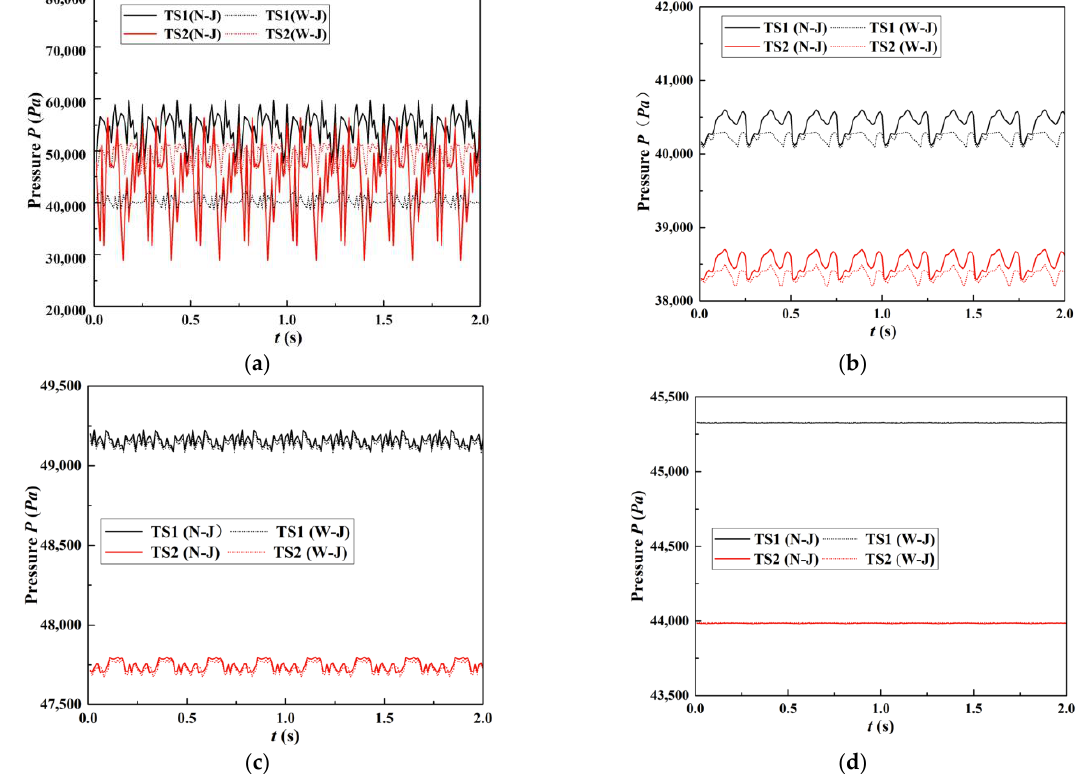
Figure 13. Pressure fluctuation at monitoring points TS1 and TS2 under four operating conditions. Through unsteady calculation, the pressure change with time at monitoring points TS1 and TS2 were obtained. Under four operating conditions, the spectrum signals of